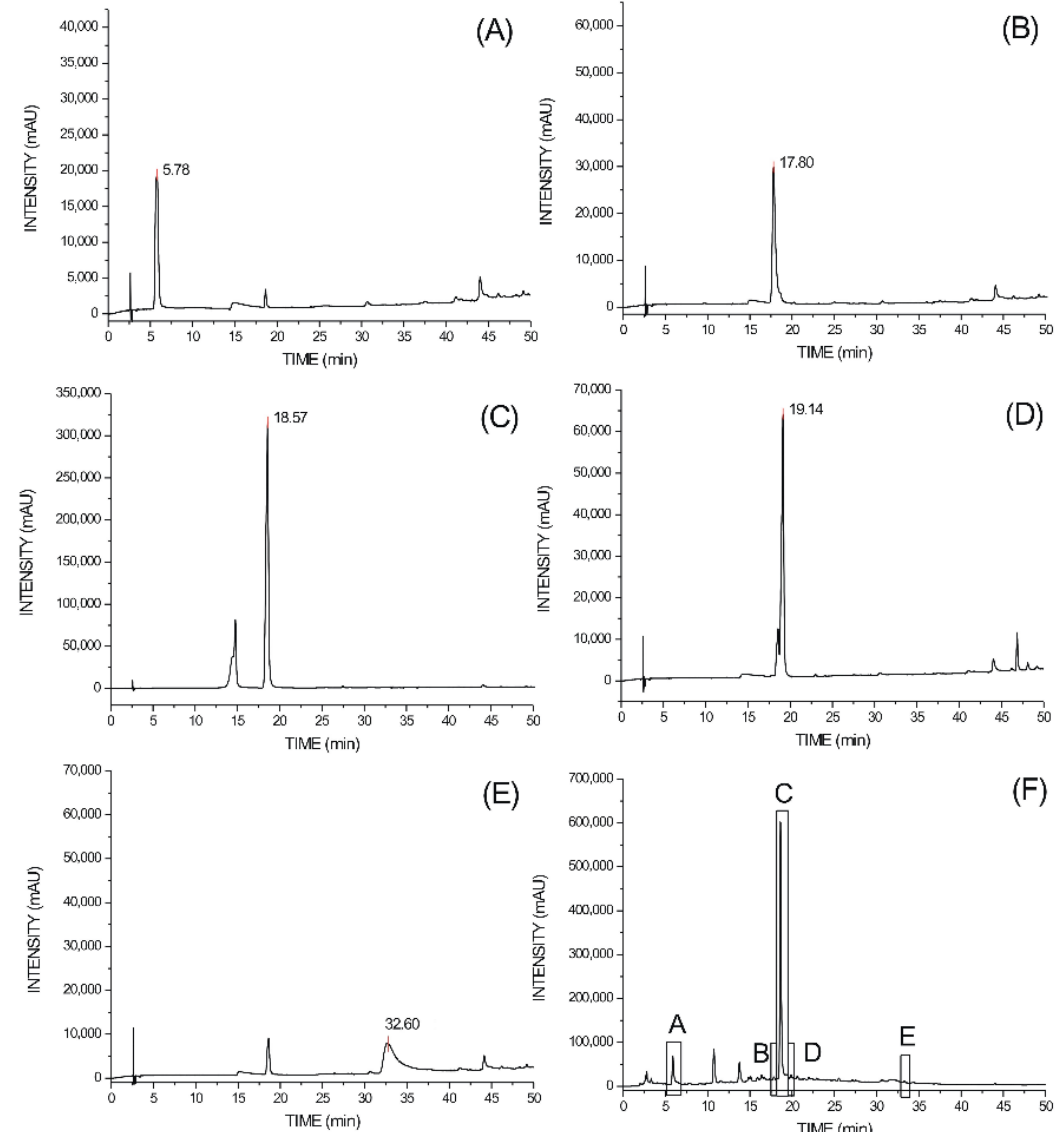
Figure 1. HPLC traces. Peaks: ( A ) gallic acid; ( B ) chlorogenic acid; ( C ) catechin; ( D ) epicatechin; ( E ) ellagic acid; ( F ) aqueous extract of S. amara stem bark (A: gallic acid; B: chlorogenic acid; C: catechin; D: epicatechin; E: ellagic